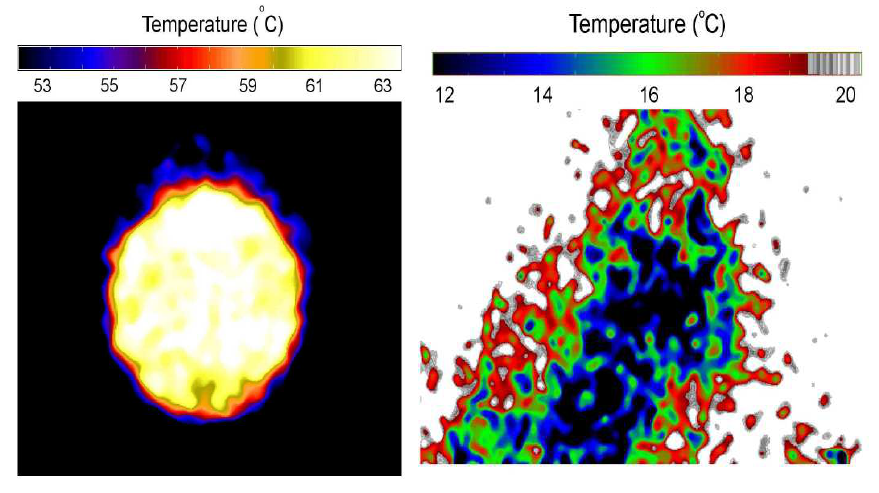
Figure 63. Examples of 2D droplet (left) and spray (right) thermometry using lifetime imaging